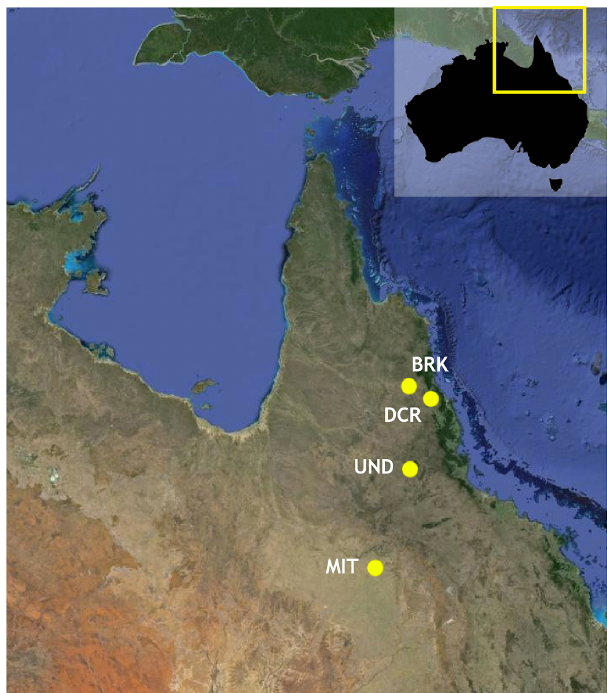
Figure 1. Geographical locations of the studied sites in northeast Australia. Source: “North East Australia” Image Landsat (2014) Google Earth.